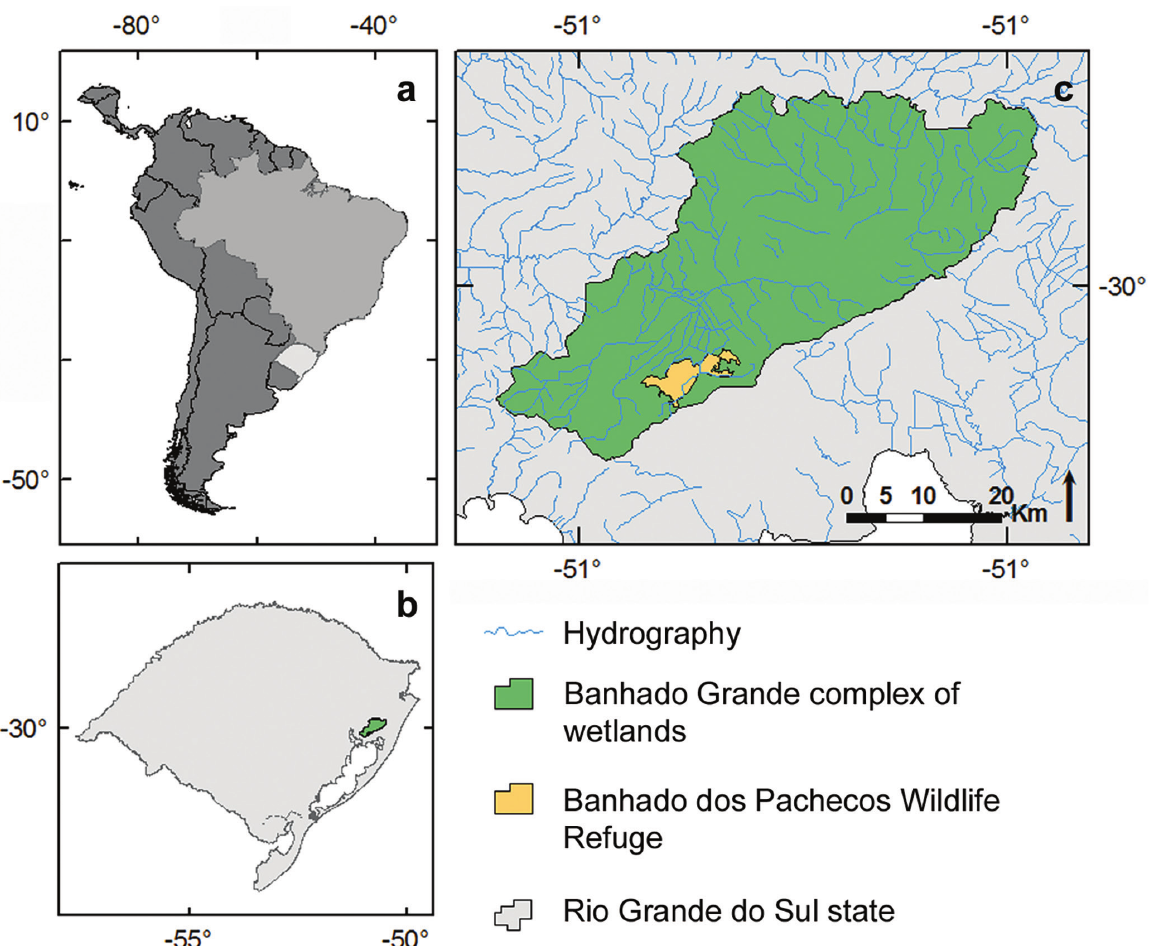
Fig. 1. Geographic location of the capture area of Atlantirivulus riograndensis . Geographical representation of South America, especially (a) Brazilian territory, (b) the state of Rio Grande do Sul and (c) Banhado dos Pachecos wildlife refuge in the city of Viamão, sampling area of Atlantirivulus riograndensis in 2012.